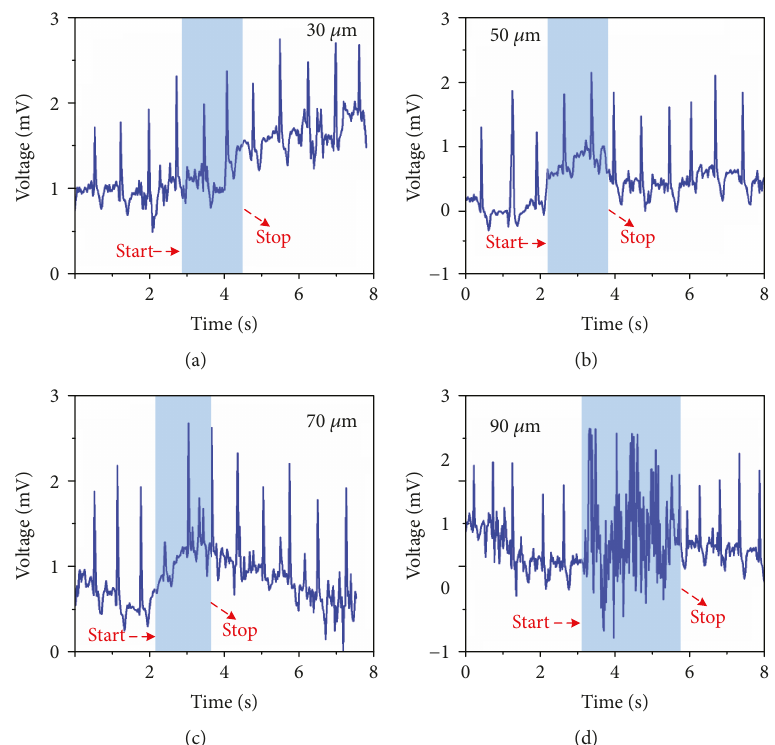
Figure 11: ECG recordings from network-shaped electrodes with di ff erent line width. (a) w = 30 μ m; (b) w = 50 μ m; (c) w = 70 μ m; and (d) w = 90 μ